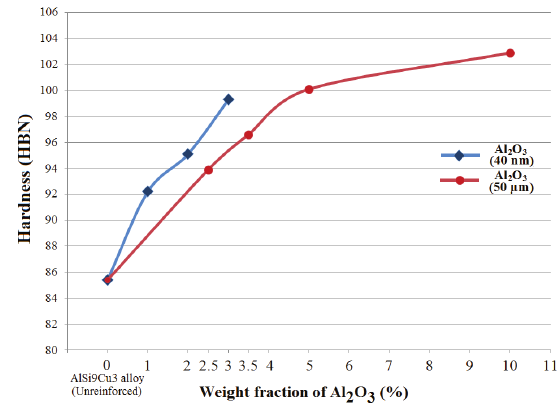
Figure 6: SEM image of fracture surface of AMMC sample with 10wt.% micro-sized Al